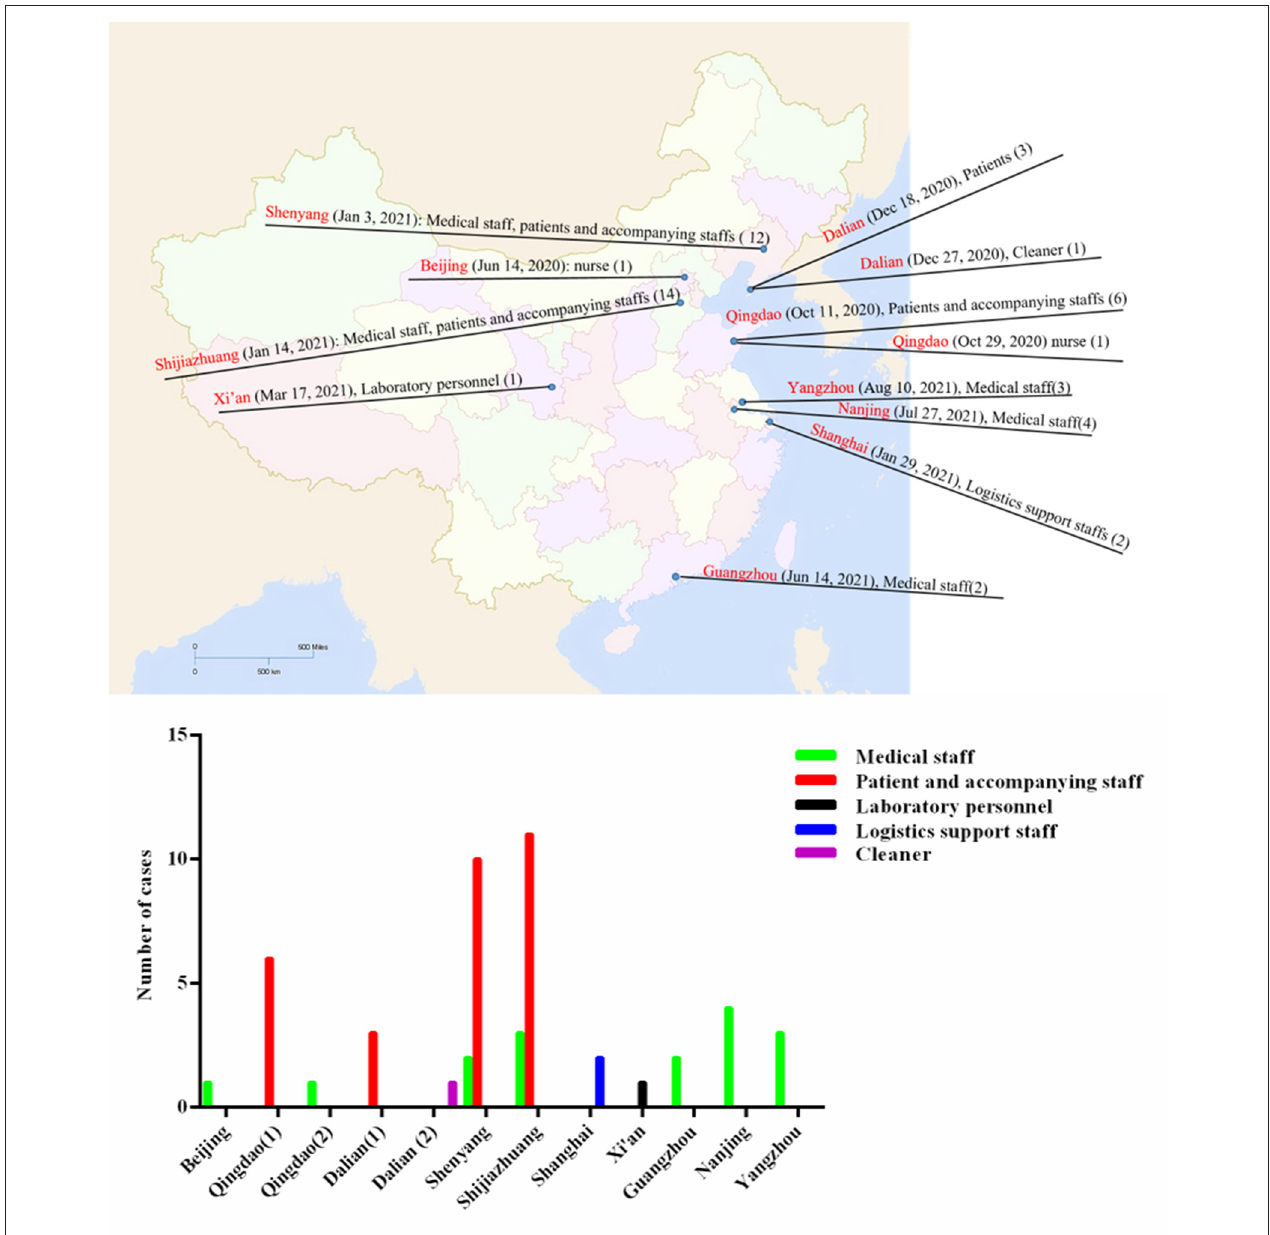
FIGURE 1 | Geographical distribution of sporadic nosocomial COVID-19 infections from June 2020 to June 2021 in China. Seven cities (Dalian, Beijing, Qingdao, Shijiazhuang, Xi’an, Guangzhou, and Shanghai) reported nosocomial COVID-19 infections. Medical staff, patients, and accompanying staff (12) in Shenyang (Jan 3, 2021), patients (3) in Dalian (Dec 18, 2020), patients and accompanying staff (6) in Qingdao (Oct 11, 2020), laboratory personnel (1) in Xi’an (Mar 17, 2021), medical staff, patients and accompanying staff (14) in Shijiazhuang (Jan 14, 2021), and Medical staff (2) in Guangzhou (Jun 14, 2021) were diagnosed as infected